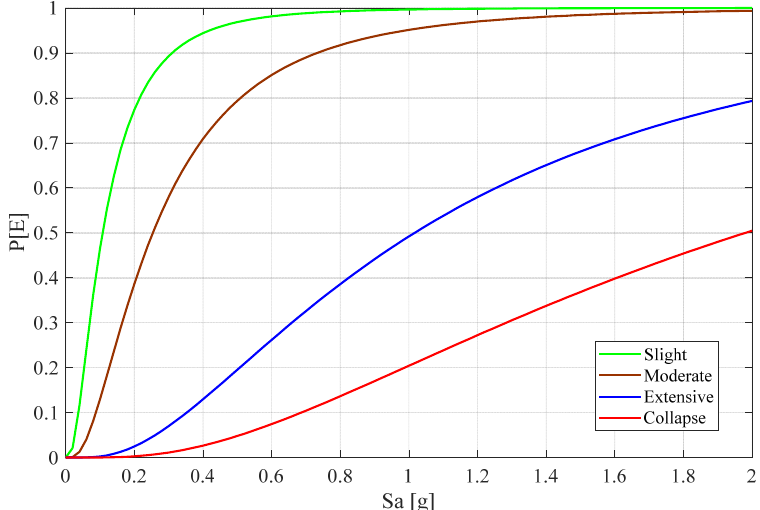
Figure 9. Fragility functions for low-rise RC building for bare frame without considering soil–struc- ture interaction. structure interaction.